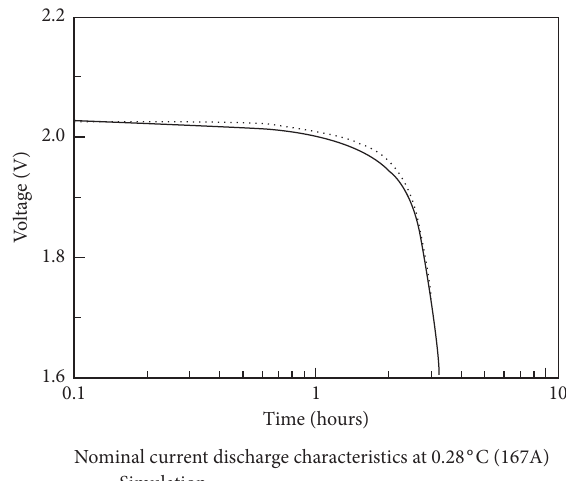
Figure 11: Comparison between nominal current discharge characteristics of the batteries installed onboard and the simulated